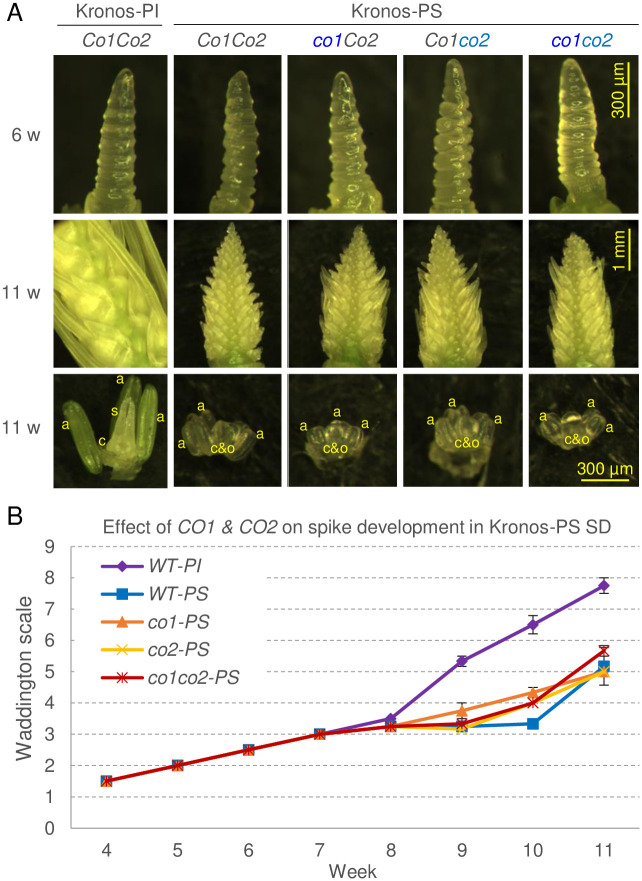
Effect of co1 and co2 mutations on spike development in Kronos-PS under SD.Kronos-PI was included as control. (A) Dissecting microscope images of developing apices at week 6 (double-ridge, W2.5) and week 11 with a detail of their floral organs. a = anthers, elongated in Kronos-PI and primordia in other genotypes, c = carpel and s = styles well developed in Kronos-PI and c&o = carpel extending around the ovule in other genotypes. (B) Developmental time course of SAM using the Waddington scale from 4- through 11-week-old plants (n = 3). W1 = vegetative apex, W2 = double ridge, W3 = glume primordium, W4 = stamen primordium, W5 = carpel extending round three sides of ovule, W6 = short style primordia and stylar canal open, W7 = stigmatic branches just differentiating as swollen cells on styles, W8 = stigmatic branches elongating, W9 = styles and stigmatic branches erect and stigmatic hairs differentiating.